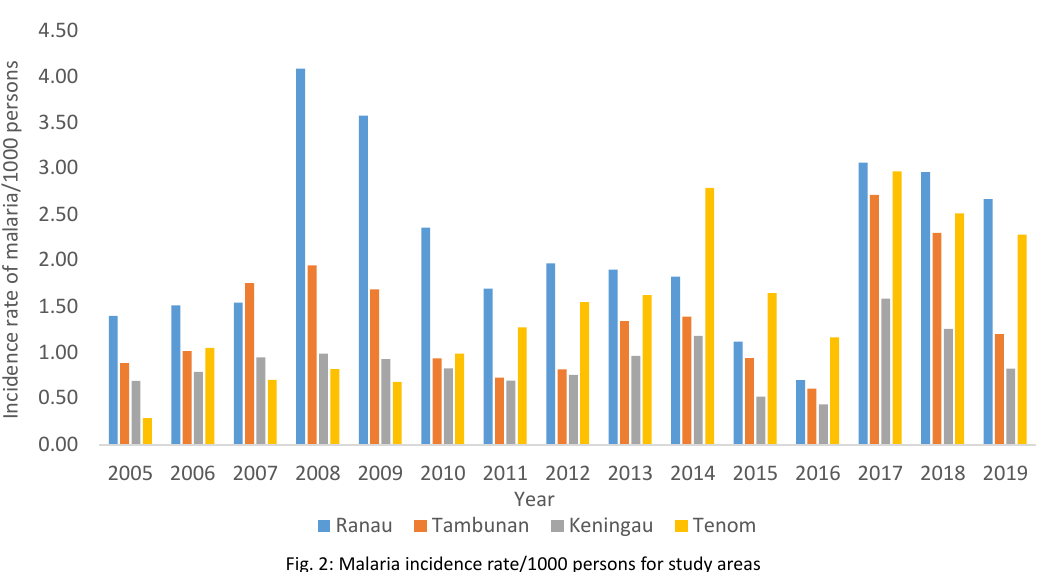
Fig. 2: Malaria incidence rate/1000 persons for study areas